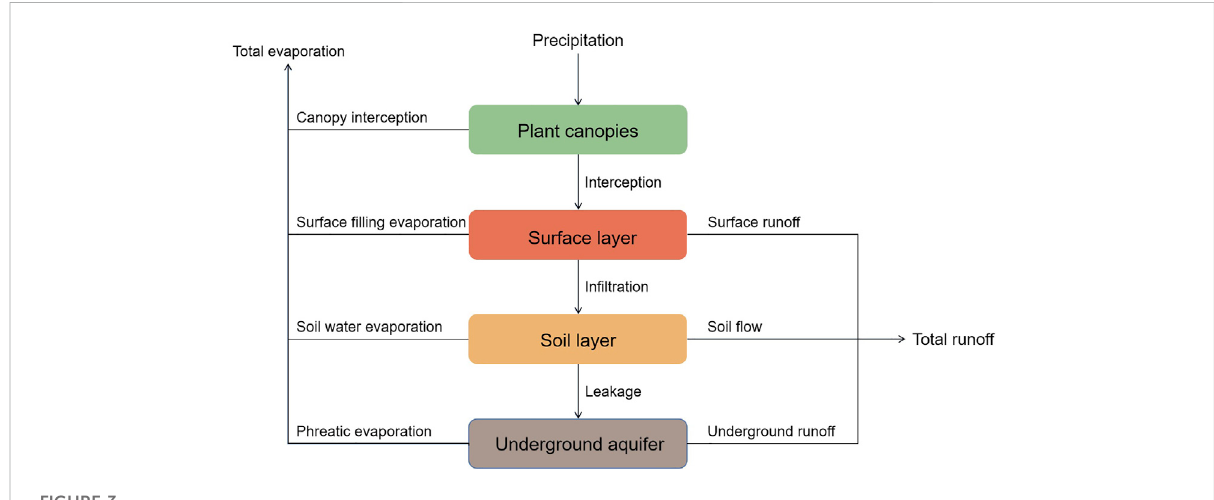
FIGURE 3 The construction of Wetspa fl ow generation